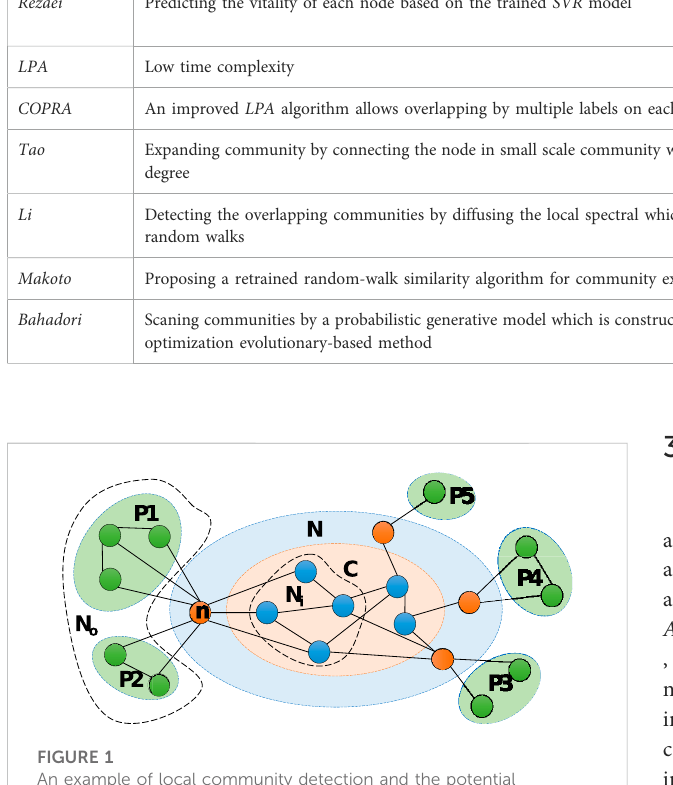
FIGURE 1 An example of local community detection and the potential communities of